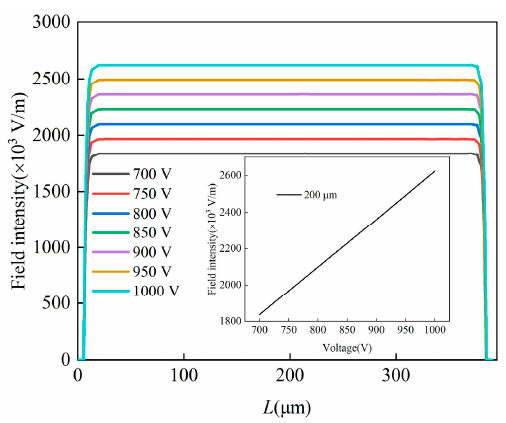
Figure 11. Variation of field intensity in the channel at different bias voltages. At a constant DC bias voltage, the electric field inside the microchannel plate can be approximated as a uniform electric field, with the electric field direction inside the channel parallel to the channel axis [28]. When the electrode penetration depth at both ends of the channel is a constant value, the higher the applied voltage, the higher the field intensity and the higher the electric field force on the electrons inside the channel. The applied voltage increases from 700 V to 1000 V and the field intensity increases linearly at 200 µ m. The larger the applied voltage, the greater the electric field force on the electrons in the channel, which will increase the number of electron collisions in the channel and, thus, increase the gain. When the electron emission is a DC mode, the secondary electron multiplication behavior at different voltage were shown in Figure 12. The gain shows an obvious increase and, especially at 1000 V, there is a sudden increase. This contributes to the increase in the number of output electrons that generates a larger secondary electron yield. It is in agreement with the variations of field intensity shown in Figure 11. This contributes to the increase in the number of output electrons generating a larger secondary electron yield.